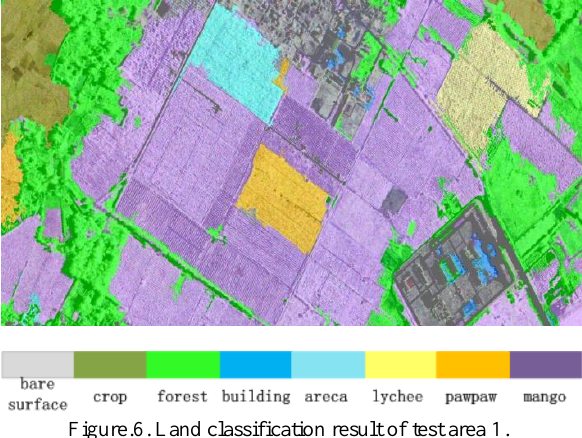
Figure.6. Land classification result of test area 1.